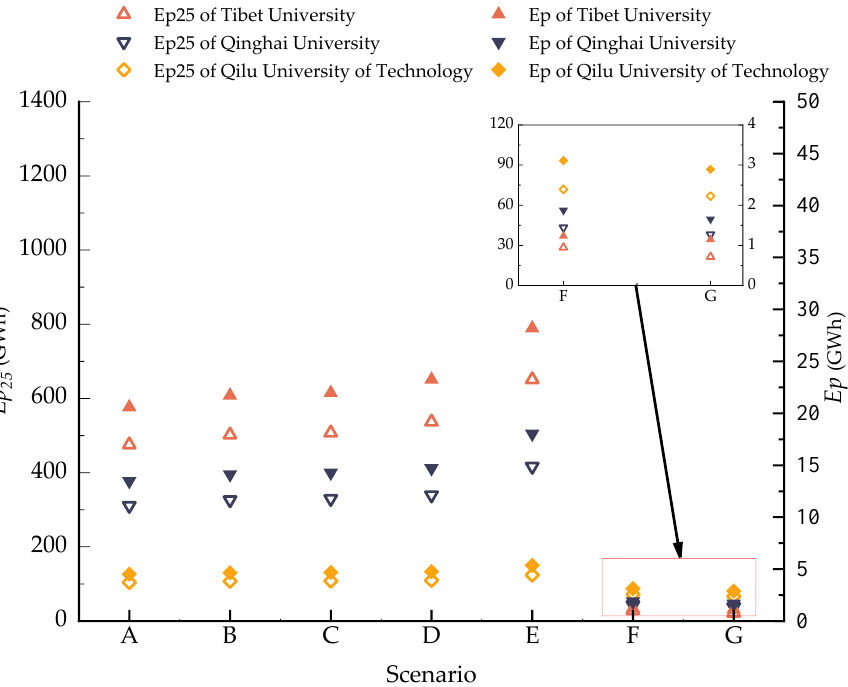
Figure 8. PV output under seven scenarios in three studied universities.